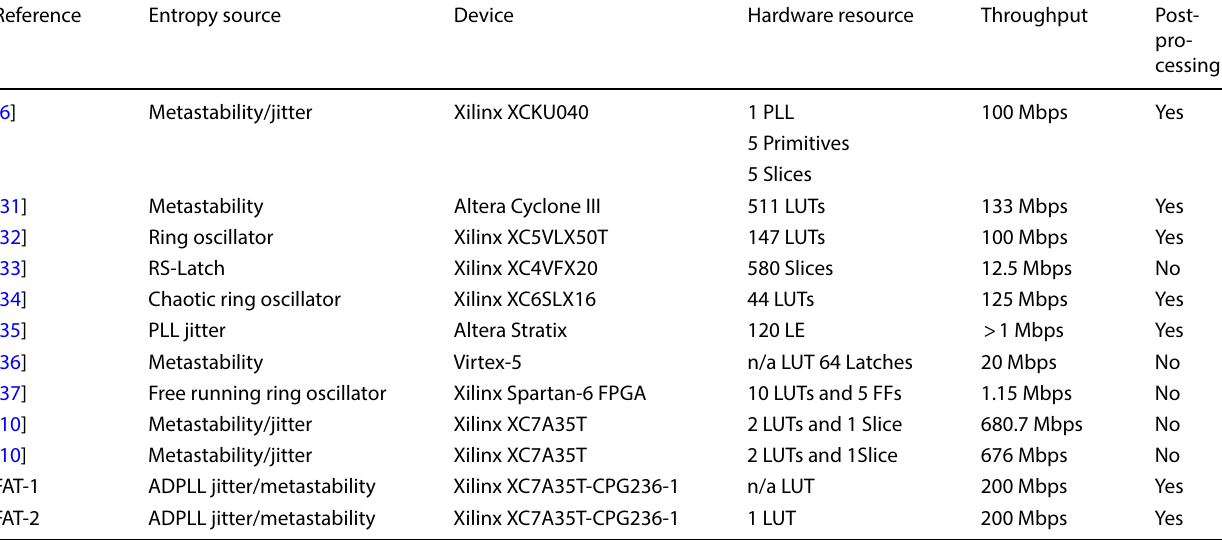
Table 8 Performance comparison among TRNG architecture Reference Entropy source Device